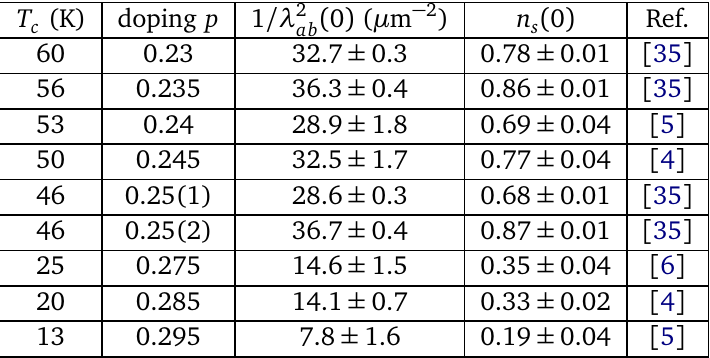
( 0 ) (per Cu) in OD Tl2201 as a func- s